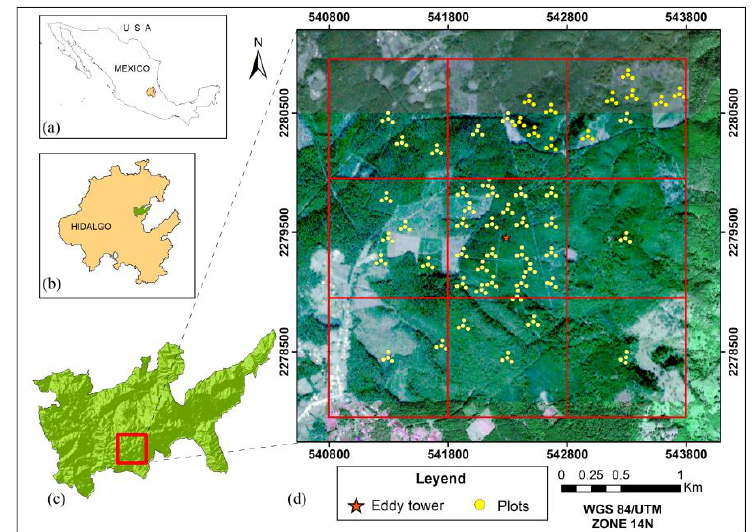
Figure 1. Study site location: ( a ) Mexico, ( b ) Hidalgo state, ( c ) Zacualtipán and plot layout. Landscape-scale sampling area (3 × 3 km) is centered on an eddy covariance tower ( d ).